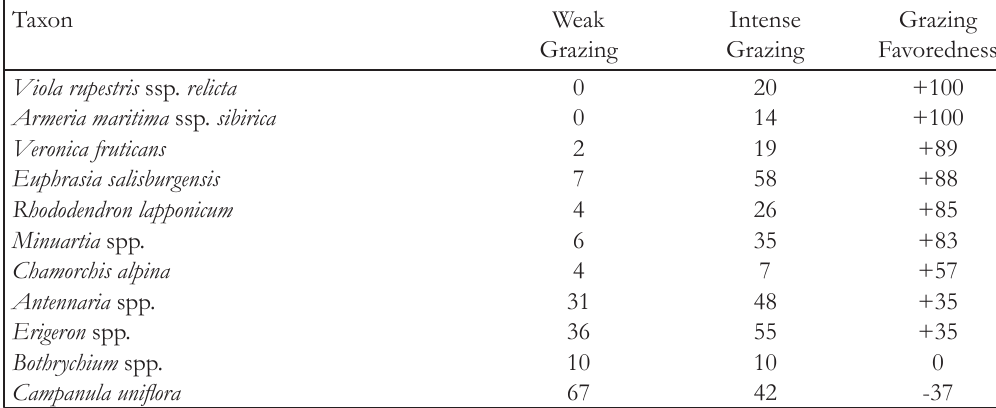
Table 4. Occurrences of plants red listed plants in Finland, Sweden or Norway on the grids representing the four least intensely grazed areas (Pikku-Malla, Iso-Malla, Saana, Geađgečorro) and in the four most intensely grazed areas (Boazuvárri, Vággečohkka, Jeahkkir, Jávrioaivit). Numbers refer to the total number of subplots where the taxon was encountered. The index of grazing favouredness is computed as 100(N where N is the number of subplots in the intensely grazed areas where the taxon in question was encounters i and N is the corresponding number for the weakly grazed w